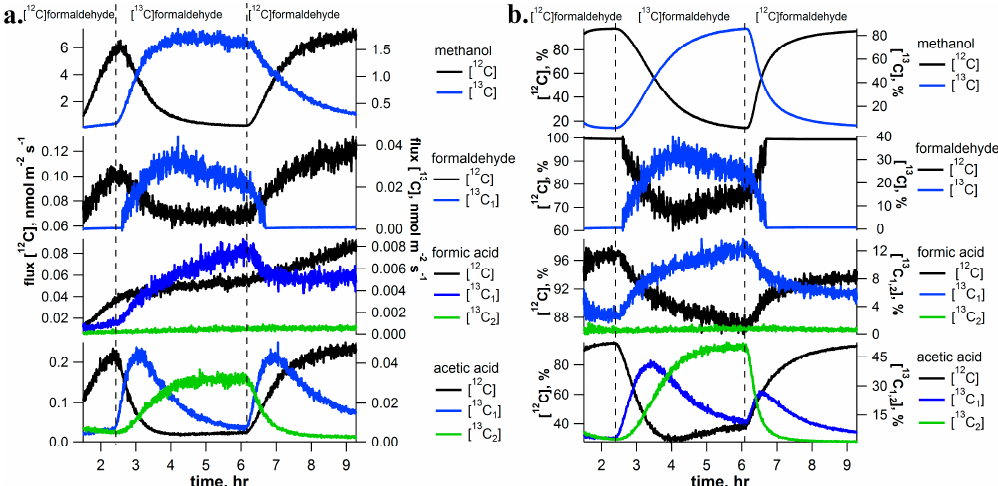
Figure 2. Example [ 13 C]formaldehyde pulse-chase experiment on a detached branch of Inga edulis showing real-time [ 13 C]labeling and unlabeling dynamics of C 1 and C 2 volatile metabolites using PTR-MS (absolute emissions in ( a ) and relative emissions in ( b )). Emissions of [ 13 C]formaldehyde was estimated by subtraction of the interference by the O 2+ ion at m / z 32. Vertical dashed lines indicate a rapid change of solutions delivered to the transpiration stream (i.e., formaldehyde to [ 13